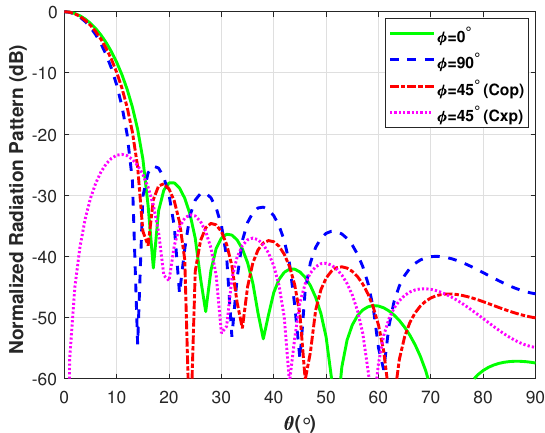
Figure 13. Normalized radiation pattern at 94 GHz of the of the optimized spline-profile horn.